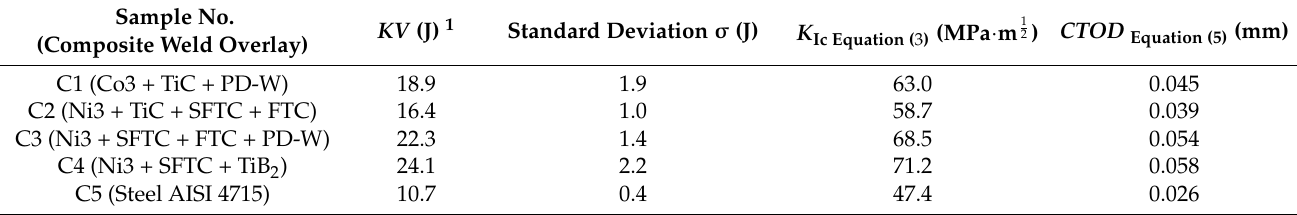
Figure 9. View of the sample before the Charpy impact test: ( a ) view from the weld overlay; ( b ) view from the Charpy V notch. Table 8. Fracture toughness K Ic and critical value of crack opening CTOD calculated based on the value of the average impact work of breaking KV at 23 ◦ C of the AISI 4715 steel parent material and steel samples with wear-resistant composite surfacing